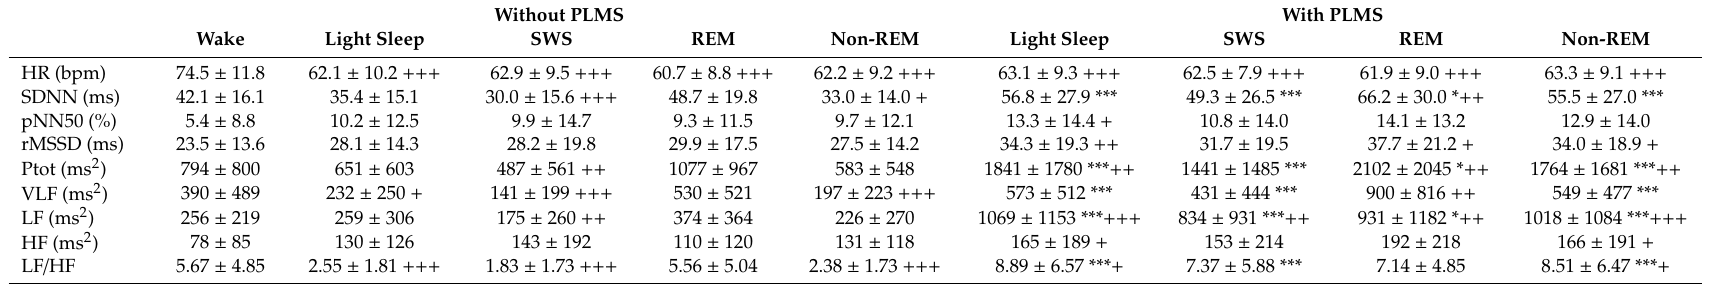
Table 2. Heart rate variability measures during wakefulness and sleep periods with and without PLMS (means ± SD). Without